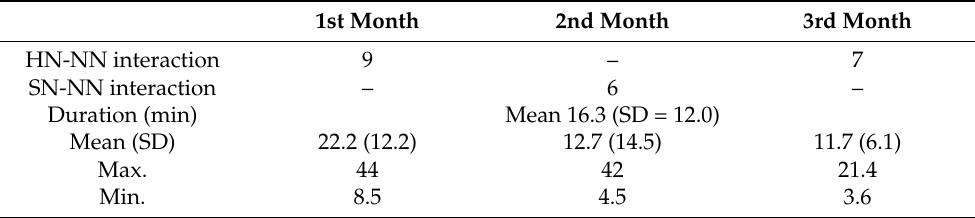
Table 3. Trimonthly